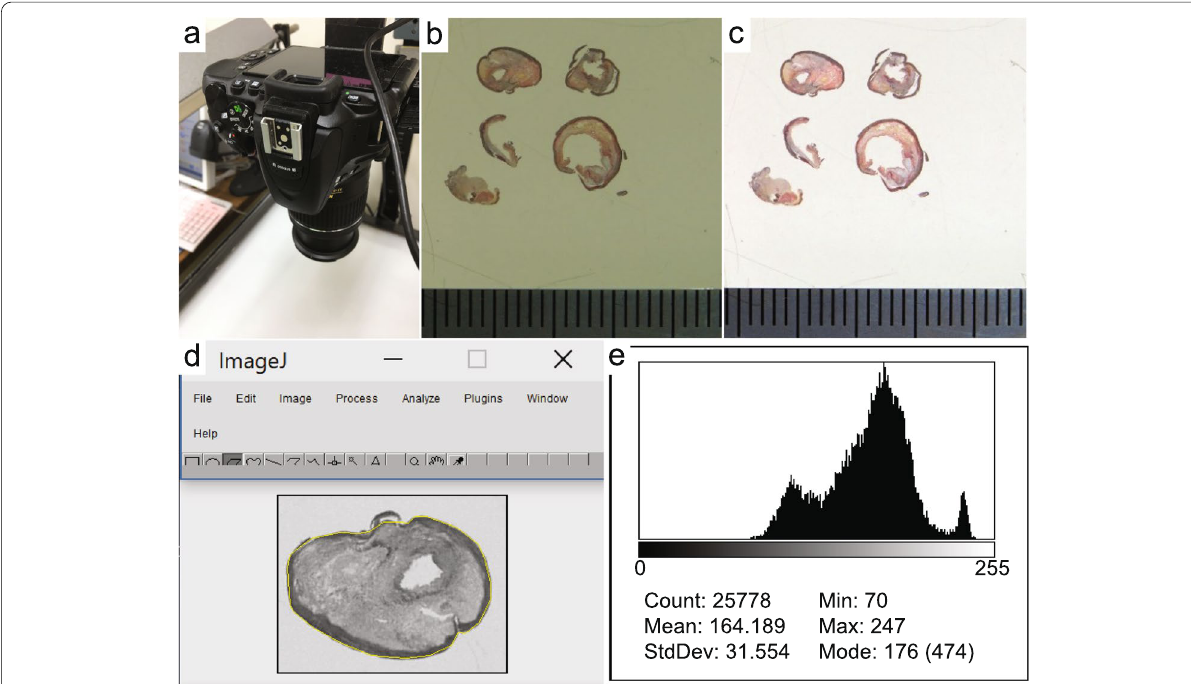
Fig. 2 a Single-lens reflex digital camera fixed on the table for specimen photography. b Image of EVG-stained specimen taken by the camera. c Post-automatic image quality adjustment. d Grayscale converted image manually surrounded by ROIs of intima and plaque. e Grayscale image converted to a histogram and the median value